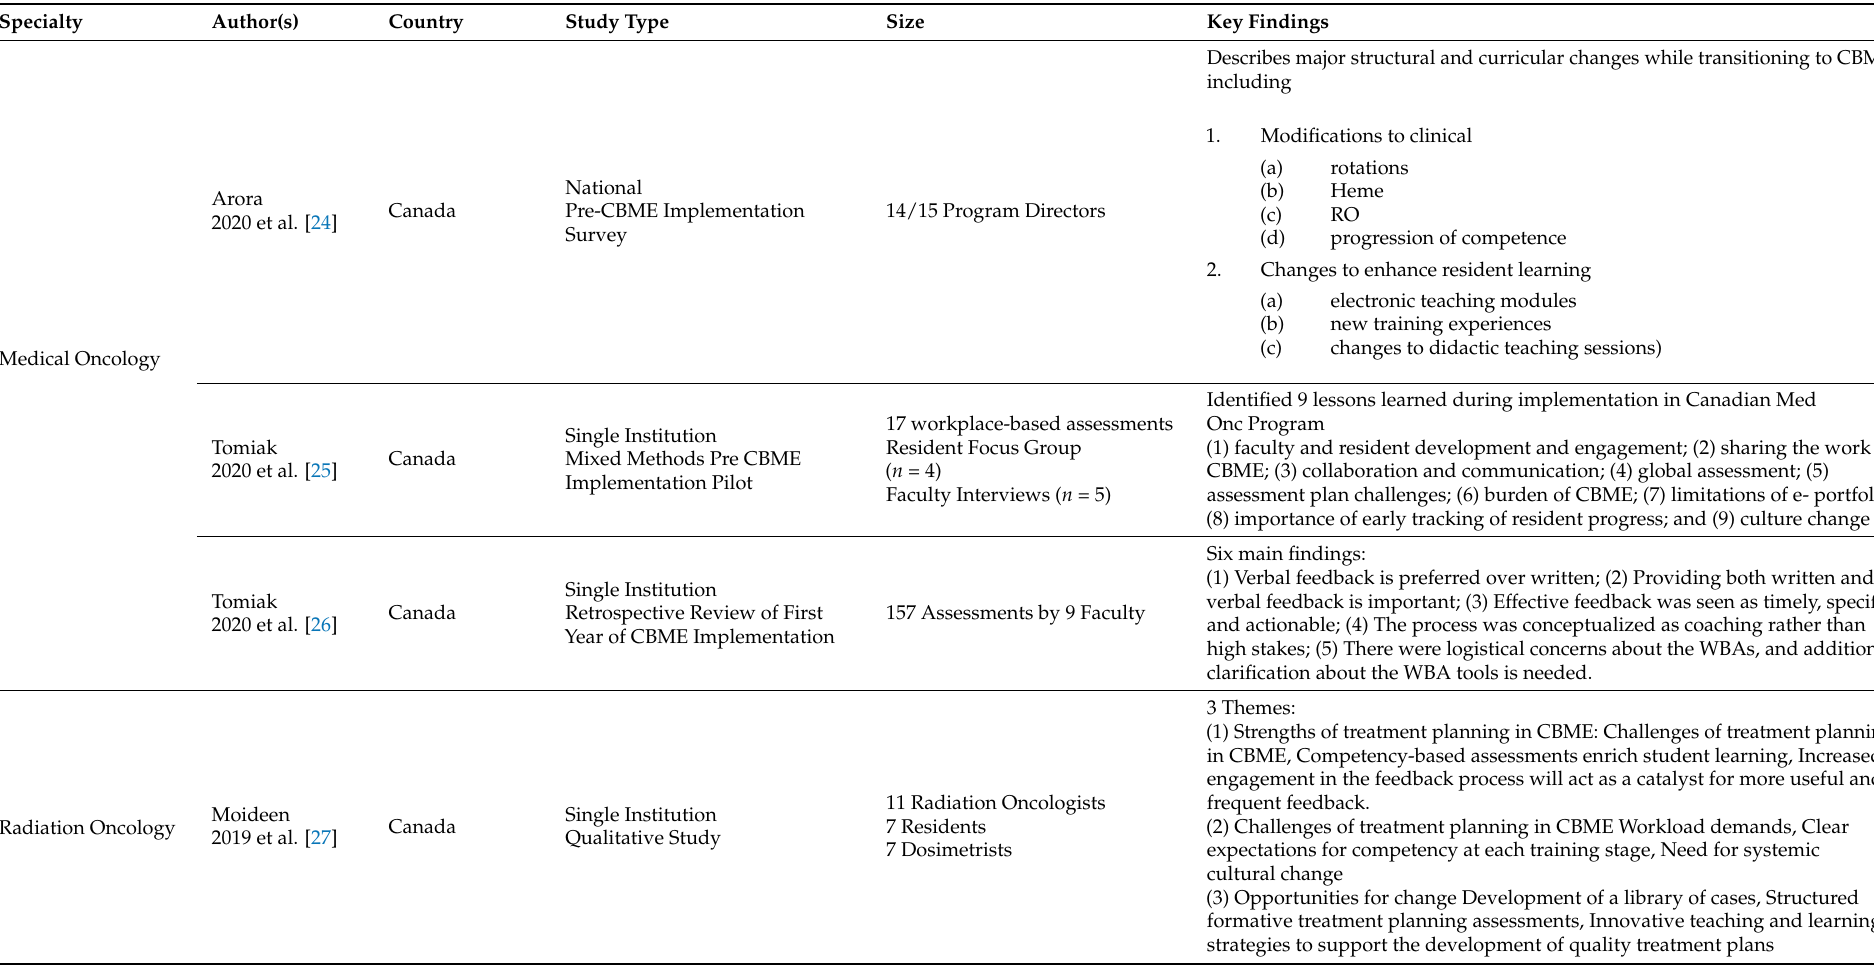
Table 2. Scoping review: papers describing implementation and evaluation of CBME for oncology medical professional training